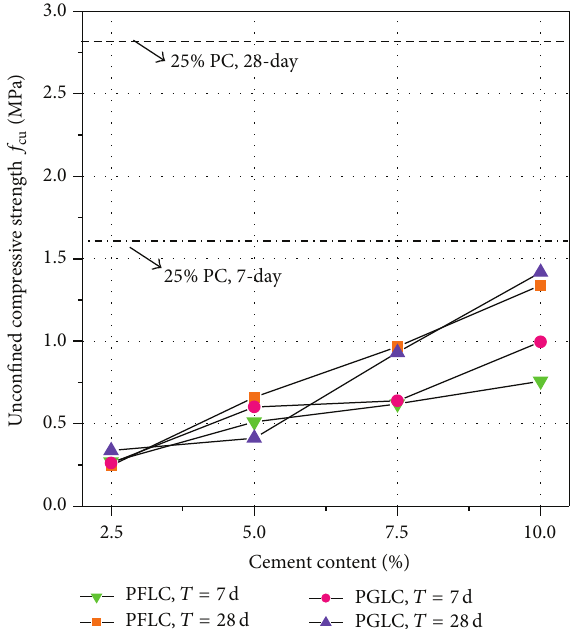
Figure 1: Relationship between 𝑓 of selected stabilized clay at 25% binder